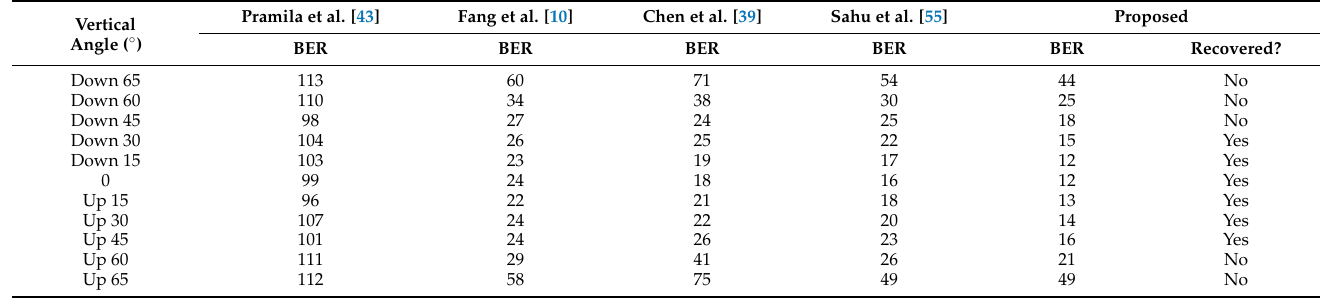
Table 9. BER values for the extracted watermark at different vertical